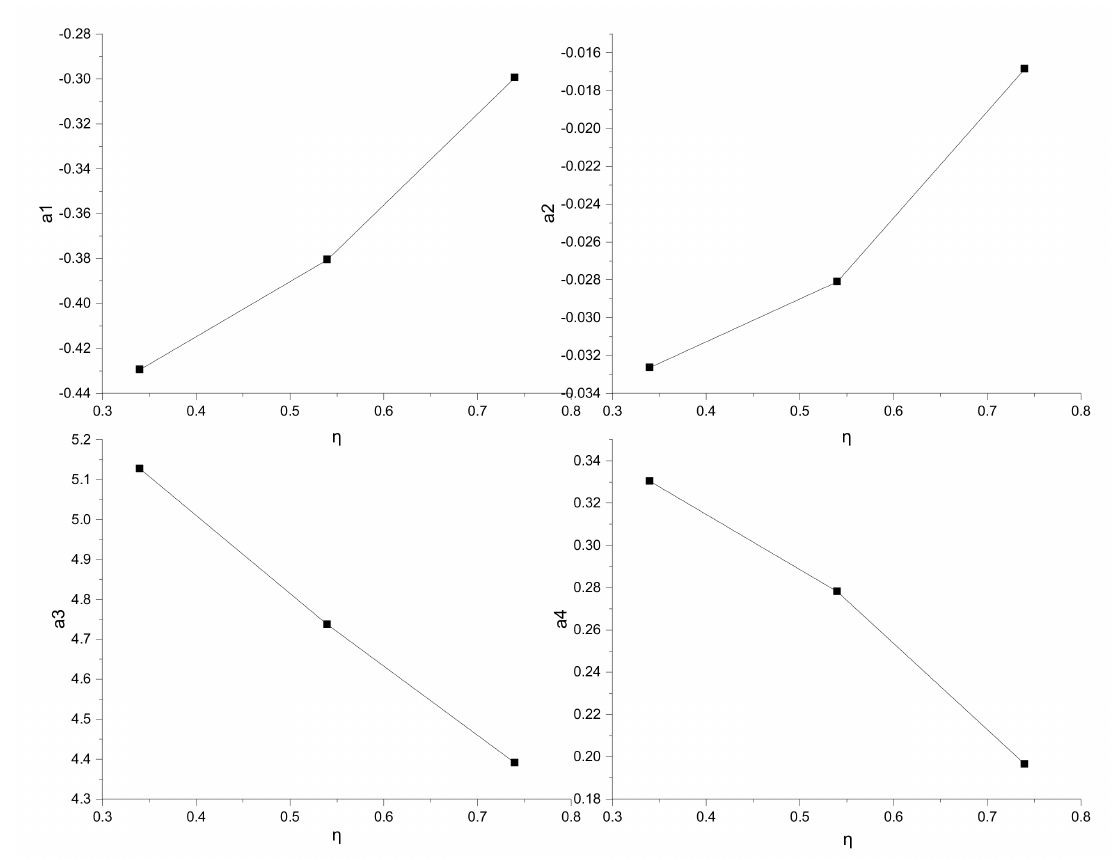
Figure 7. The relationship between coe ffi cient a1, a2, a3, a4 and η